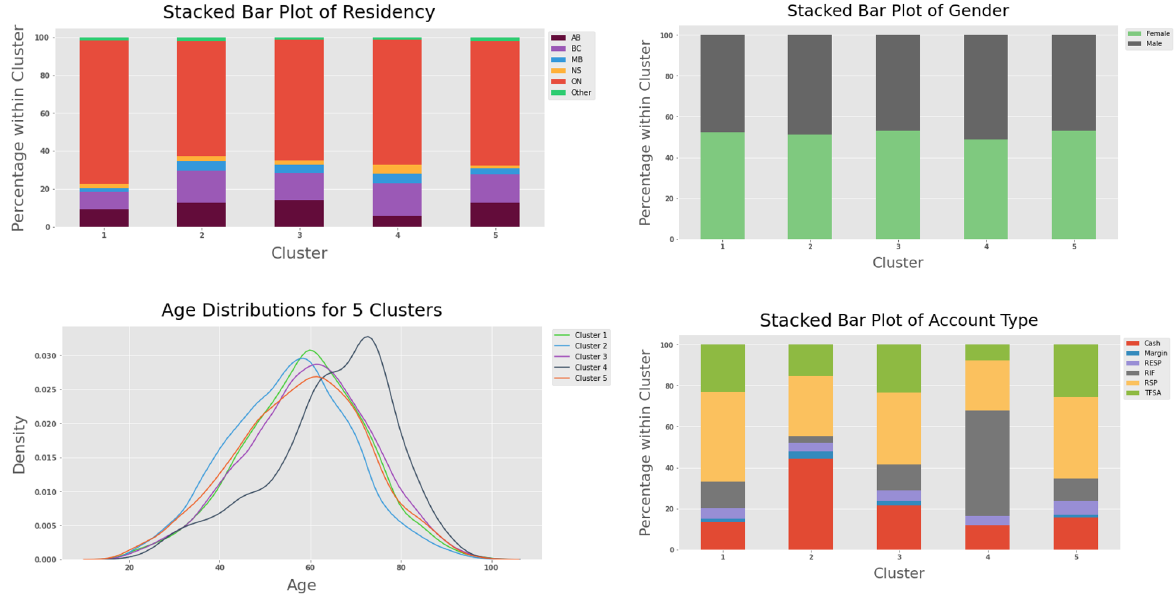
Figure 7. Categorical and numerical distributions of clusters. ( Top left ) panel shows the residency distribution, ( top right ) shows the gender distribution, ( bottom left ) shows the age distribution, and ( bottom right ) shows the account type distribution for each